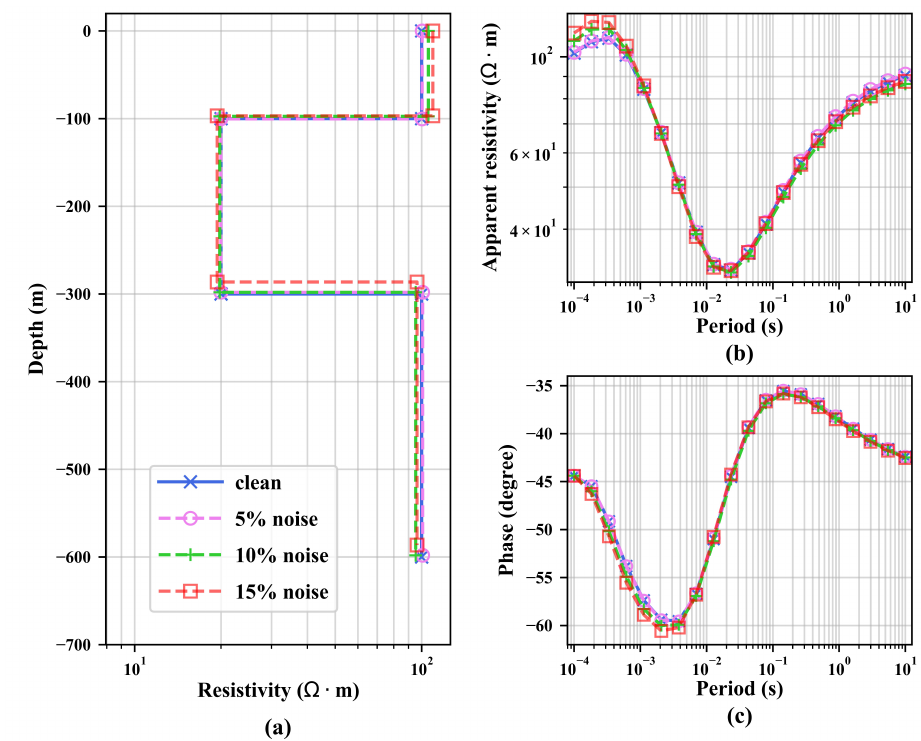
Figure 10. The predicted three-layer geoelectric models and their MT responses under noisy con- ditions. ( a – c ) represent the geoelectric model, apparent resistivity responses and phase responses, respectively. The blue lines represent the supposed three-layer electrical model and clean MT re- sponses, and the purple lines represent the predicted geoelectric model and its MT responses when the noise level is 5%. The green lines represent the predicted geoelectric model and its MT responses when the noise level is 10%. The red lines represent the predicted geoelectric model and its MT responses when the noise level is 15%. Table 3. Comparison of the accuracy of the predicted three-layer geoelectric model under different noise